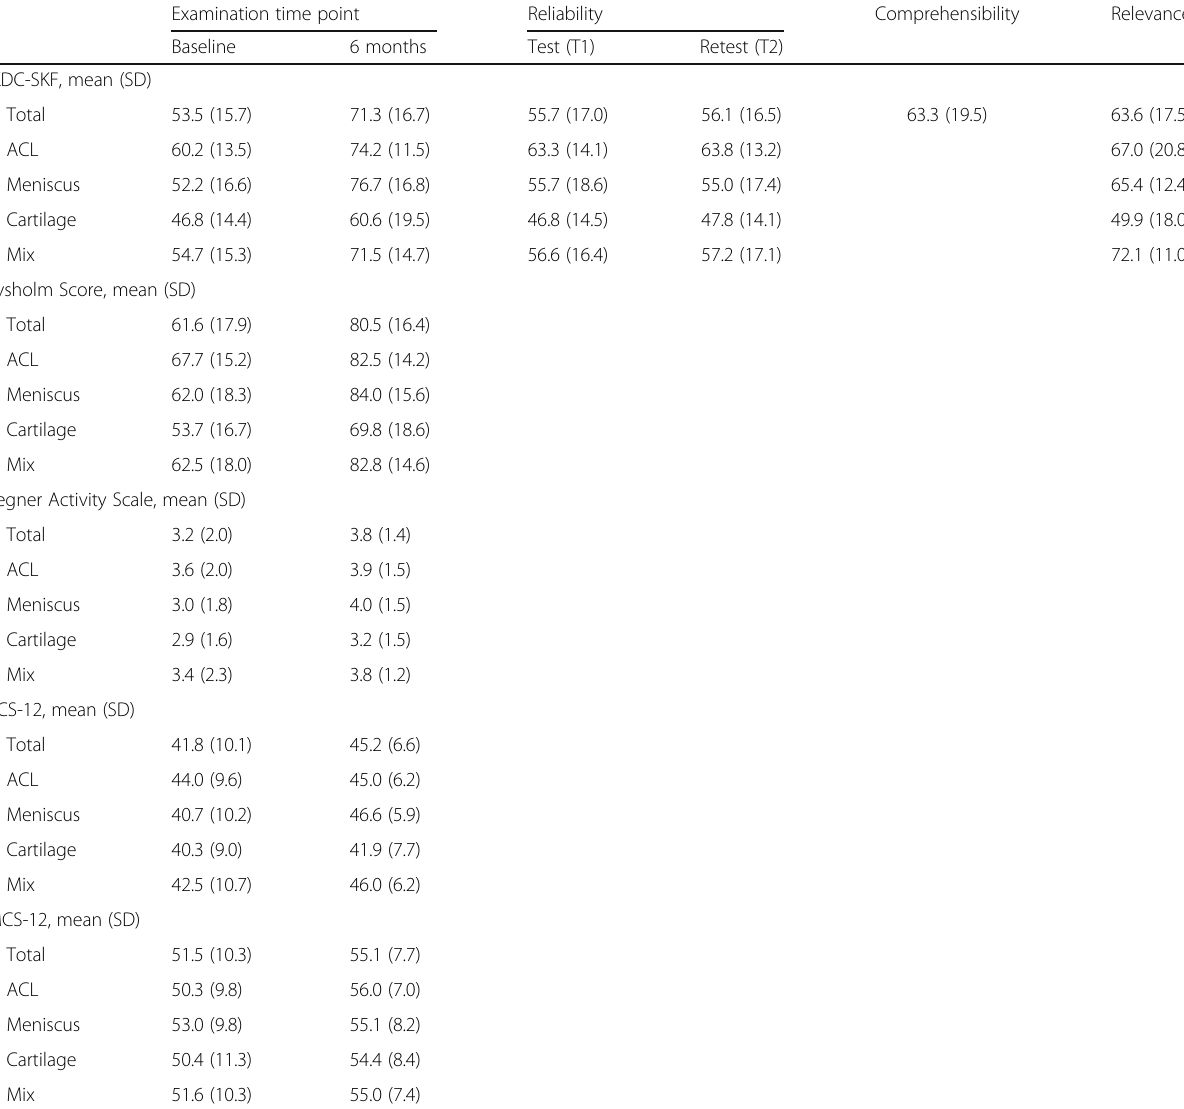
Table 1 Questionnaire scores for the total population as well as each patient subgroup Examination time point